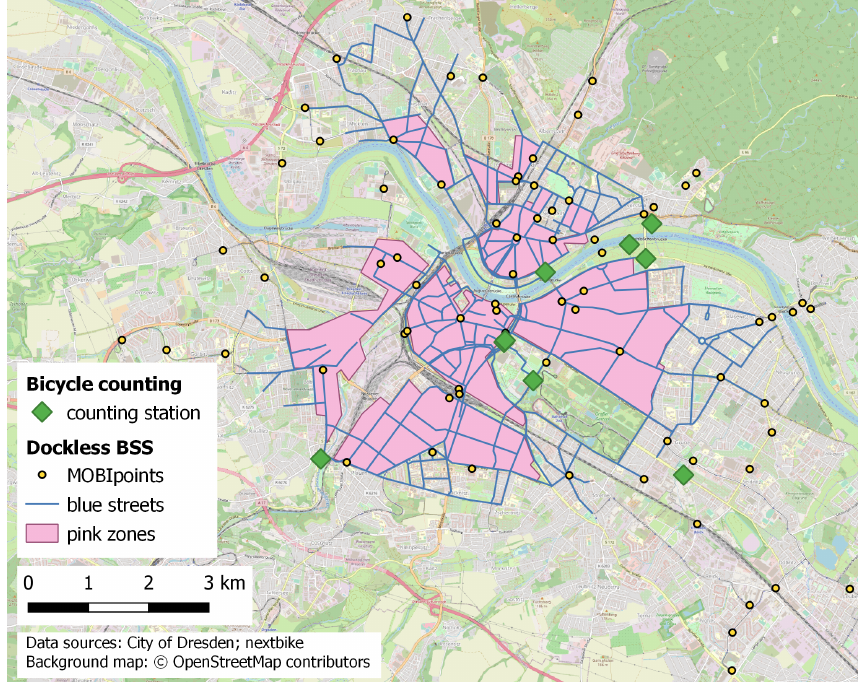
Figure 12. Positions of bicycle counting stations and the different return zones of MOBI bicycles in Dresden, where returning a bicycle at MOBIpoints and on blue streets is free of charge, while returning on a pink zone is charged with 1 Euro and outside the other areas with 20